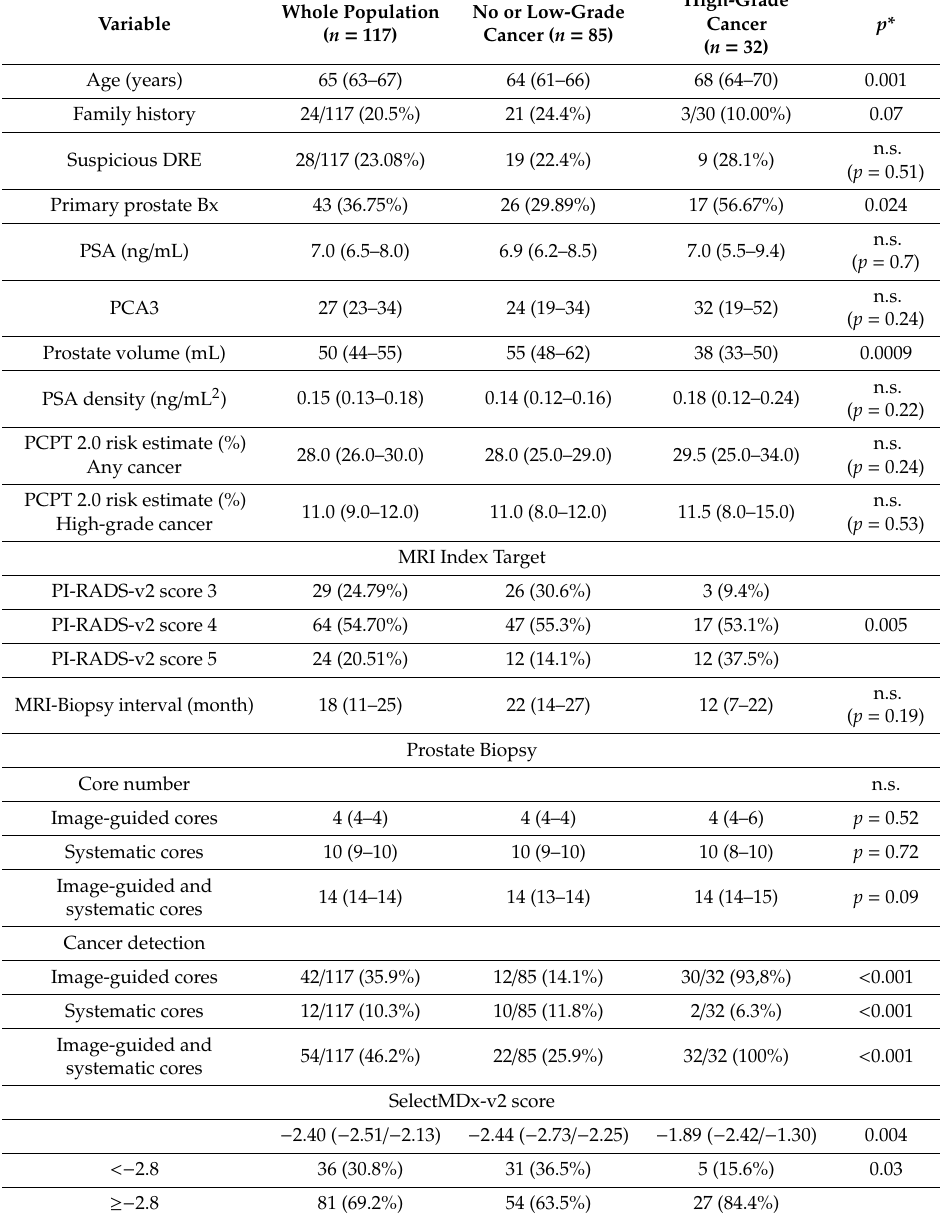
Table 1. Patient characteristics and biopsy results according to the 2016 World Health Organization classification and the 2014 International Society of Urological Pathology consensus conference on Gleason grading of prostatic carcinoma, and to the technique used to procure biopsies. Medians and 95% confidence intervals are presented for quantitative